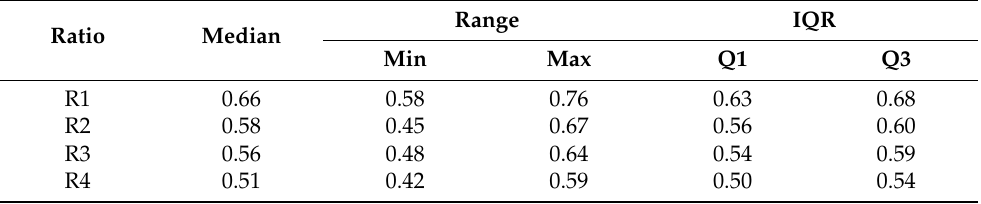
Table 2. The ratios calculated based on the measured length values. Range IQR Ratio Median Min Max Q1 Q3 R1 0.66 0.58 0.76 0.63 0.68 R2 0.58 0.45 0.67 0.56 0.60 R3 0.56 0.48